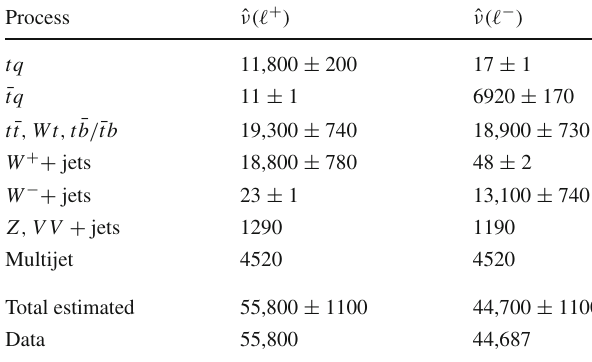
Table3 Eventyieldsforthedifferentprocessesestimatedwiththefitto the O NN distribution compared tothe numbers of observed events. Only the statistical uncertainties are quoted. The Z , V V + jets contributions and the multijet background are fixed in the fit; therefore no uncertainty is quoted for these processes